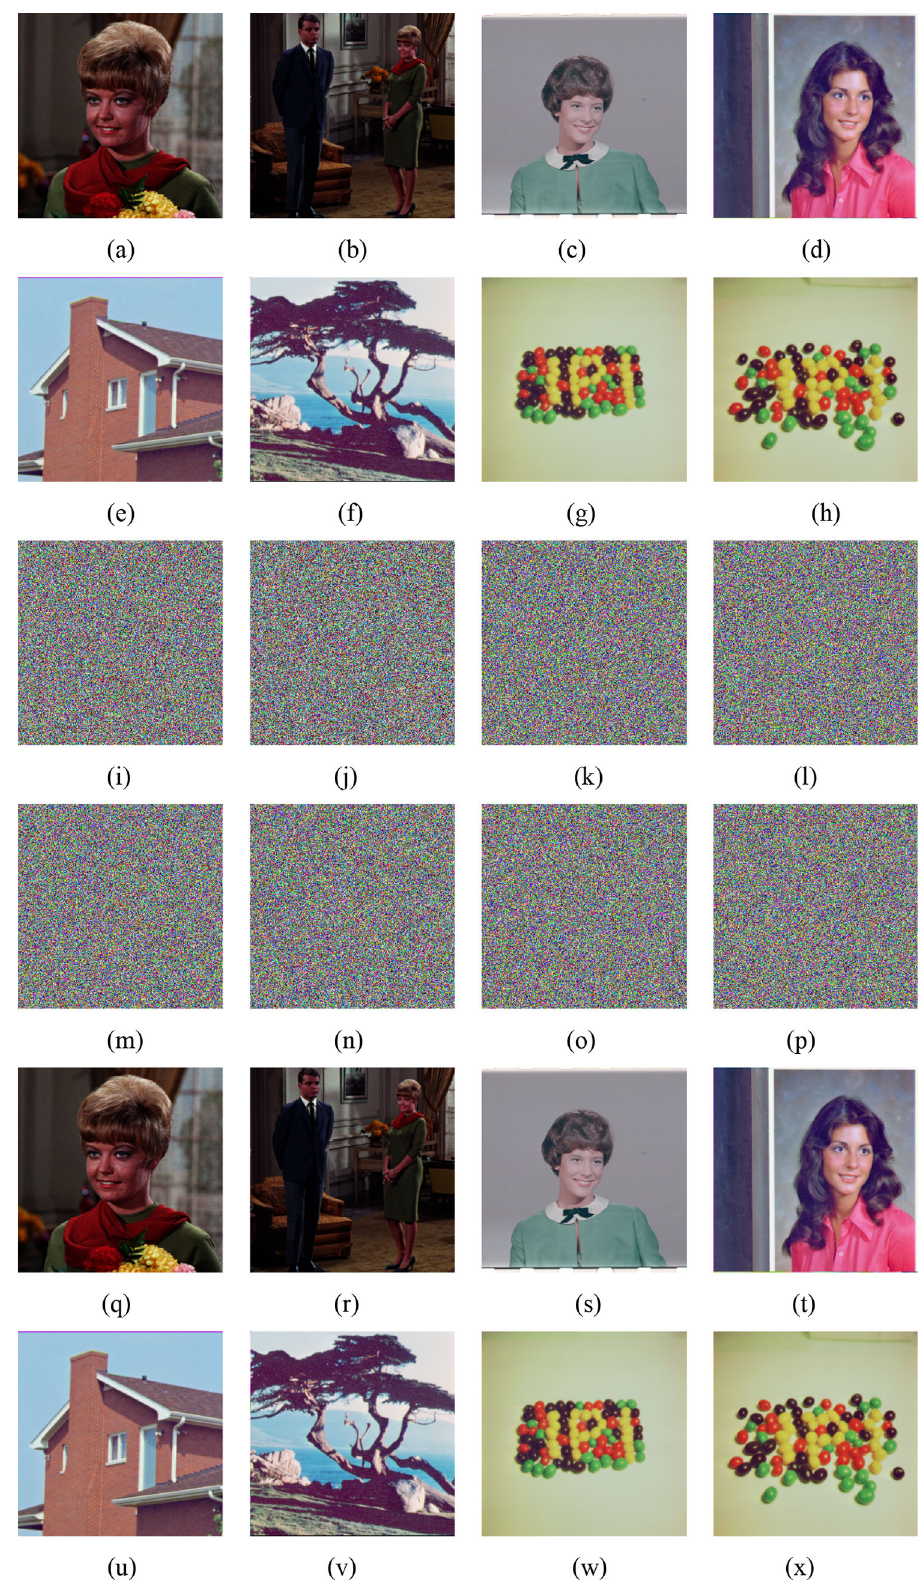
Fig. 9 Encryption and decryption results of eight test